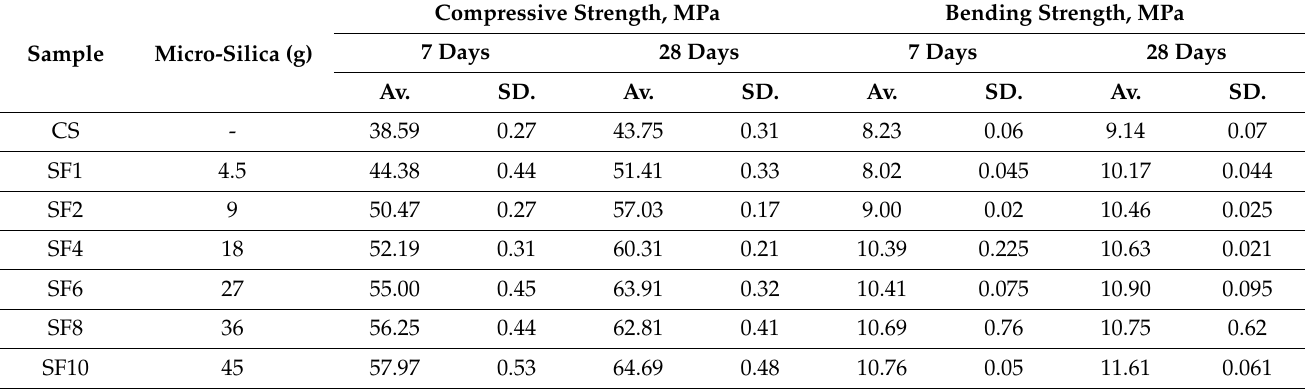
Table 7. Compressive and bending strength of mortar containing